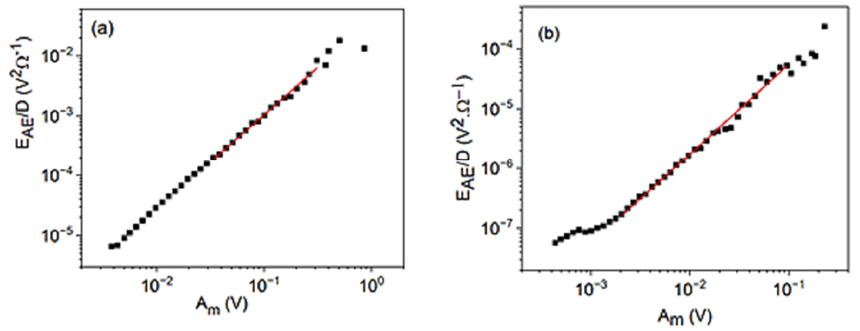
Figure 9. log E AE versus logA m plots for cooling in alloy A ( a ) at small, constant, external magnetic field (B = 250 mT) and for heating in alloy B ( b ) (at B = 0). The slopes are 1.6 ± 0.1 and 1.65 ± 0.05, respectively.